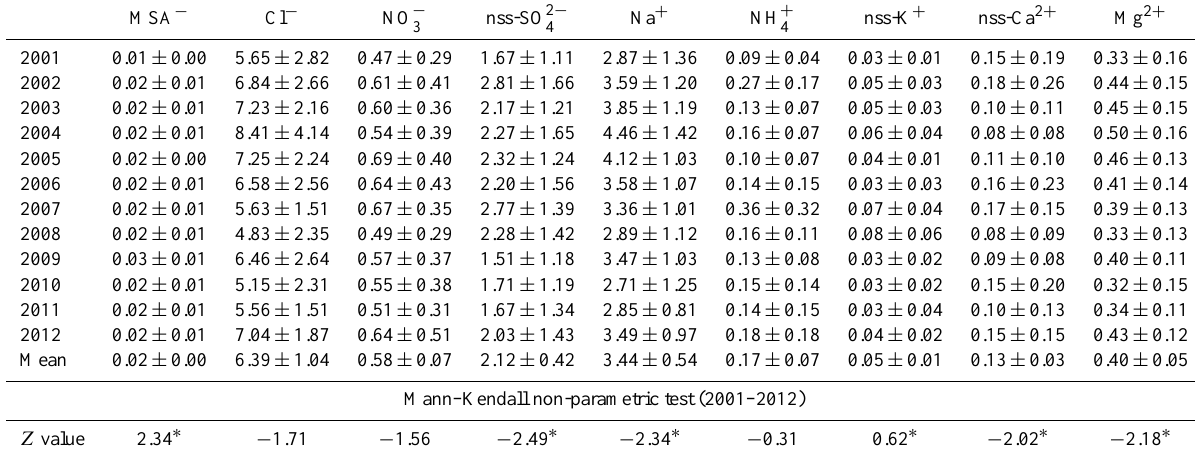
Table 2. Annual mean concentrations of major inorganic ions (mean ± SD) and the Mann–Kendall test for annual trends during 2001–2012 at Chichijima Island in the western North